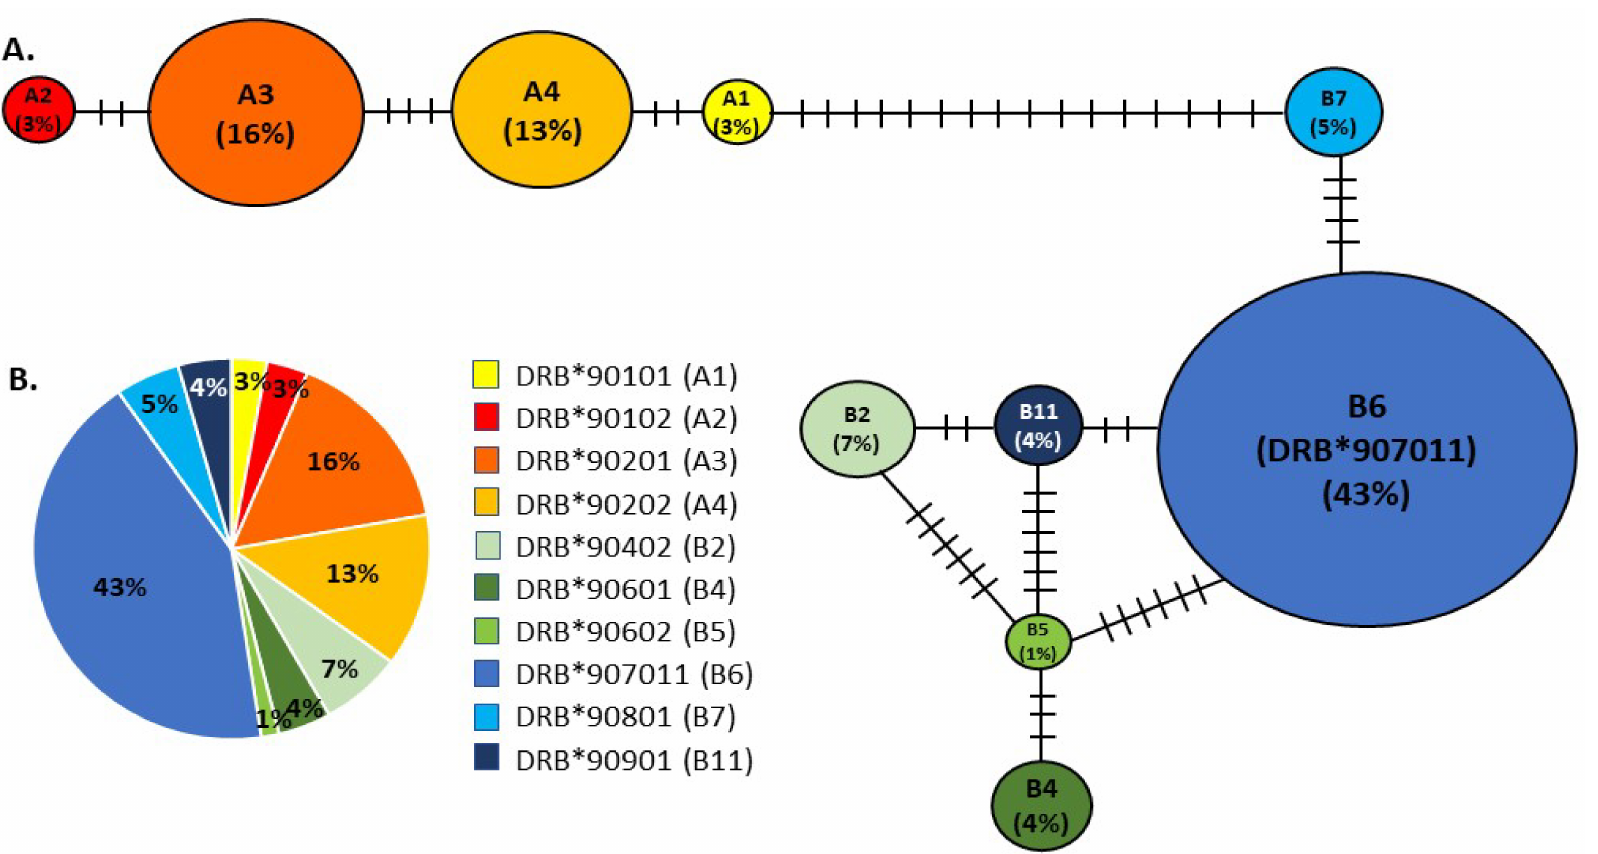
Figure 1. (A ) Minimum spanning network of MHC DLA-DRB1 haplotypes identified in sampled APD from the NA population. Sizes of the circles represent the frequency of the haplotype in the population; hatch marks represent the number of mutational events separating haplotypes. ( B ) Pie chart illustrating the relative frequencies of each DLA-DRB1 haplotype in the NA